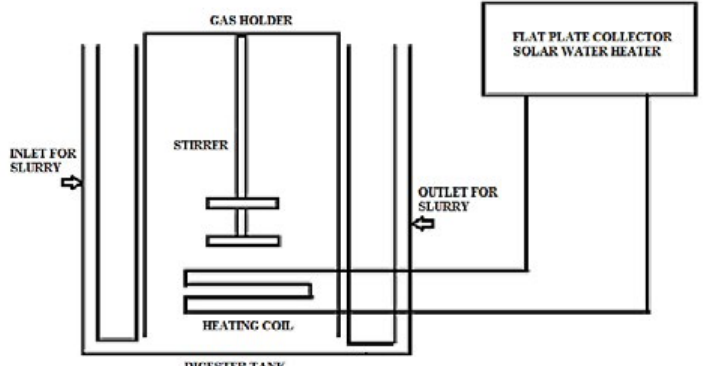
Fig. 2: Schematic representation of the prototype digester of 230 L capacity with a stirrer and solar heating of the digester